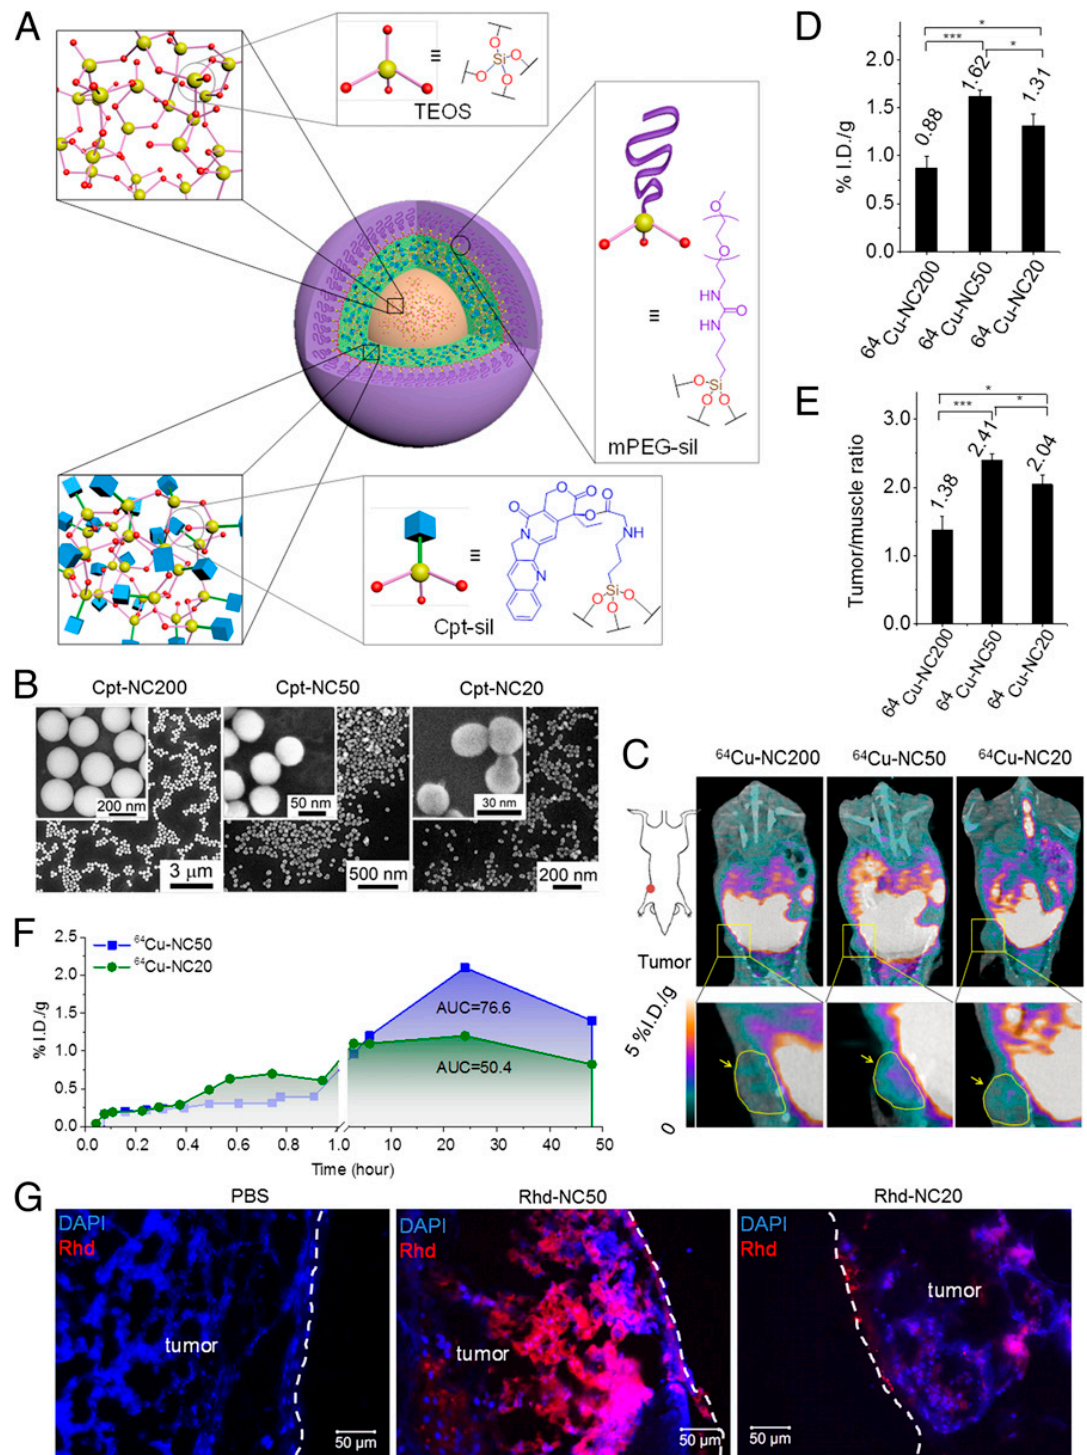
Figure 3. ( A ) Illustration of the size-controlled drug silica nanocarriers. ( B ) Cpt nanocarriers SEM scans. ( C – E ) In vivo bio-distribution of 64 Cu-NCs in mice with MCF-7 human breast tumors. All of the data are represented as the average ± SEM and analyzed by one-way ANOVA (Fisher; 0.01 < * p ≤ 0.05; *** p ≤ 0.001 ( F ) Kinetic observation of tumor growth of 64 Cu-NC20 and 64 Cu-NC50. ( G ) Ex vivo tumor clearance analysis in MCF-7 tumors. Re-printed with permission from reference [133]. Copyright (2014), Proceedings of the National Academy of Sciences (PNAS).